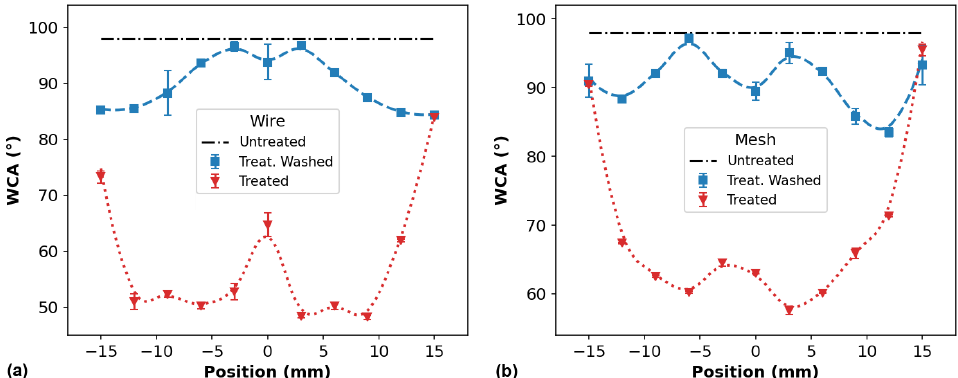
Figure 9. Comparison between WCA profiles of treated PP samples before and after washing for the APPJ treatment performed with ( a ) wire and ( b ) mesh mountings. The distance between plasma outlet and target was 6